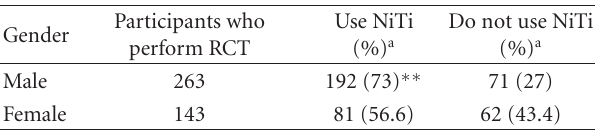
Table 5: Response details for RCT performance and NTRF in relation to gender.